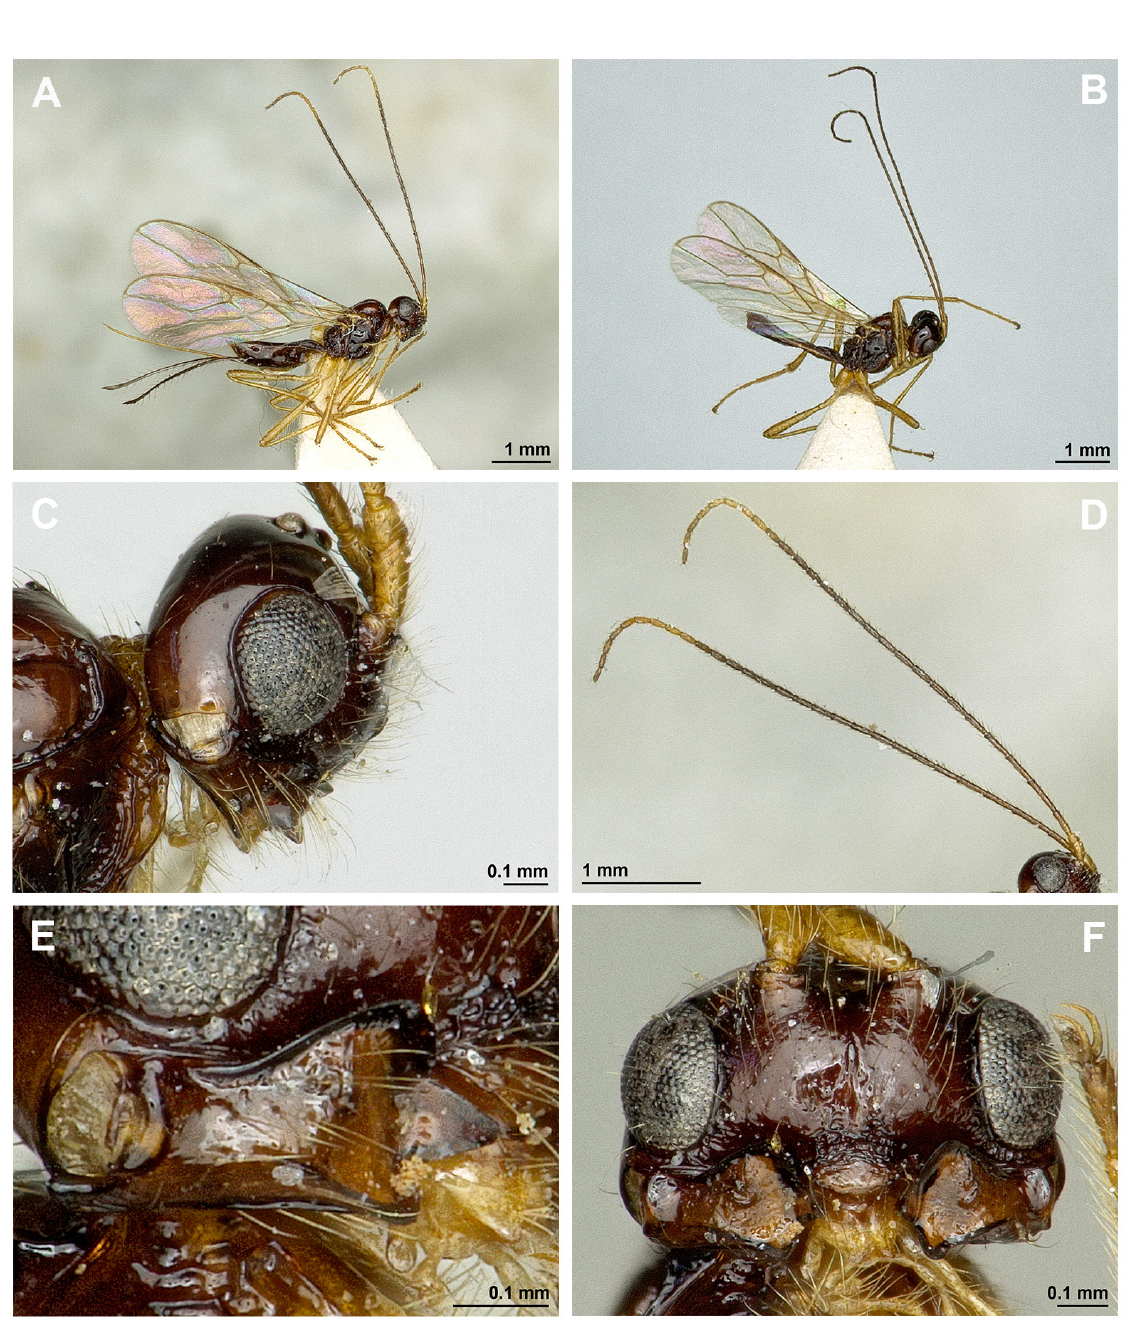
Fig. 66. Asobara turneri Peris-Felipo, 2014, A, C–F: ♀, holotype (BMNH); B: ♂ (BMNH). A–B . Habitus, lateral view. C . Head, lateral view. D . Antenna. E . Mandible. F . Head, front